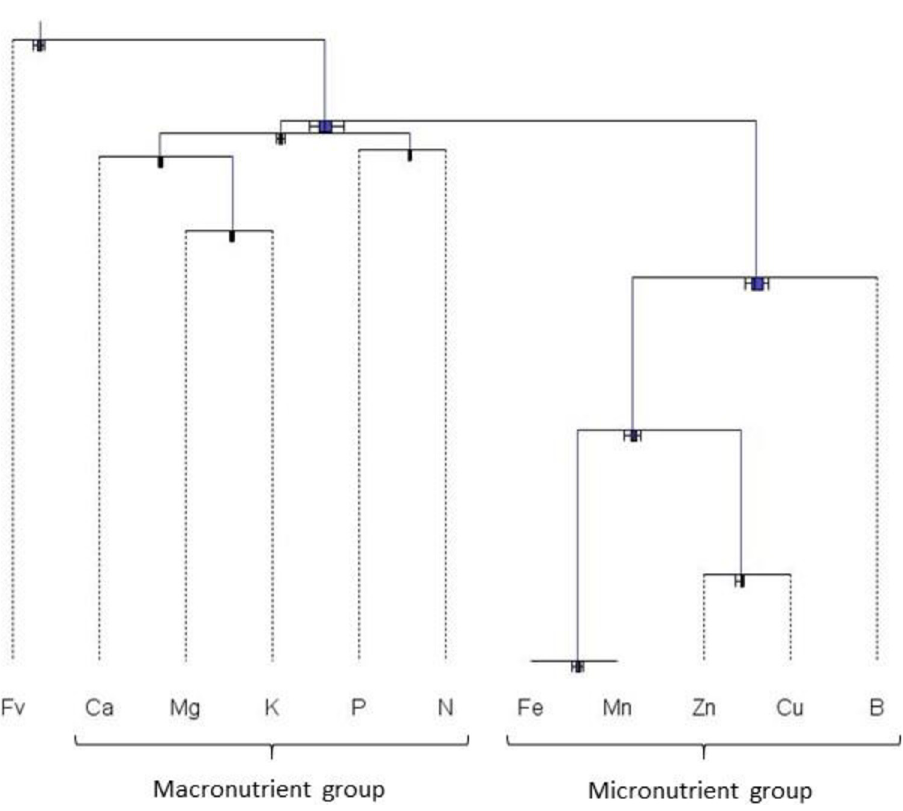
Fig 2. Dendrogram to analyze macro- and micronutrients separately (Fv = filling value).